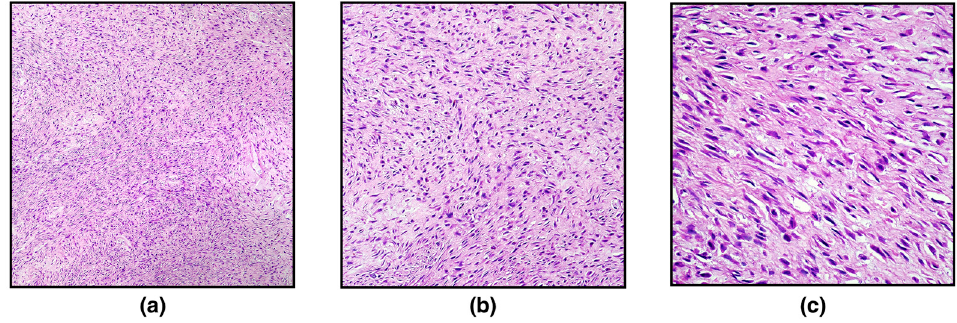
Figure 1. Leiomyoma, ovary, white tiger. Hematoxylin and eosin (HE). ( a ) Neoplastic cells are arranged in interlacing fascicles and in a herringbone pattern, embedded in a collagenous connec- tive tissue (magnification, 100 × ); ( b ) spindle-shaped neoplastic cells showed minimal atypia and polymorphism (magnification, 200 × ); ( c ) higher magnification (400 × ). With the Masson Trichrome staining, the cytoplasm of smooth muscle cells was stained red, and thin, abundant, blue-stained collagen bundles intersected between indi- vidual neoplastic cells (Figure 2).